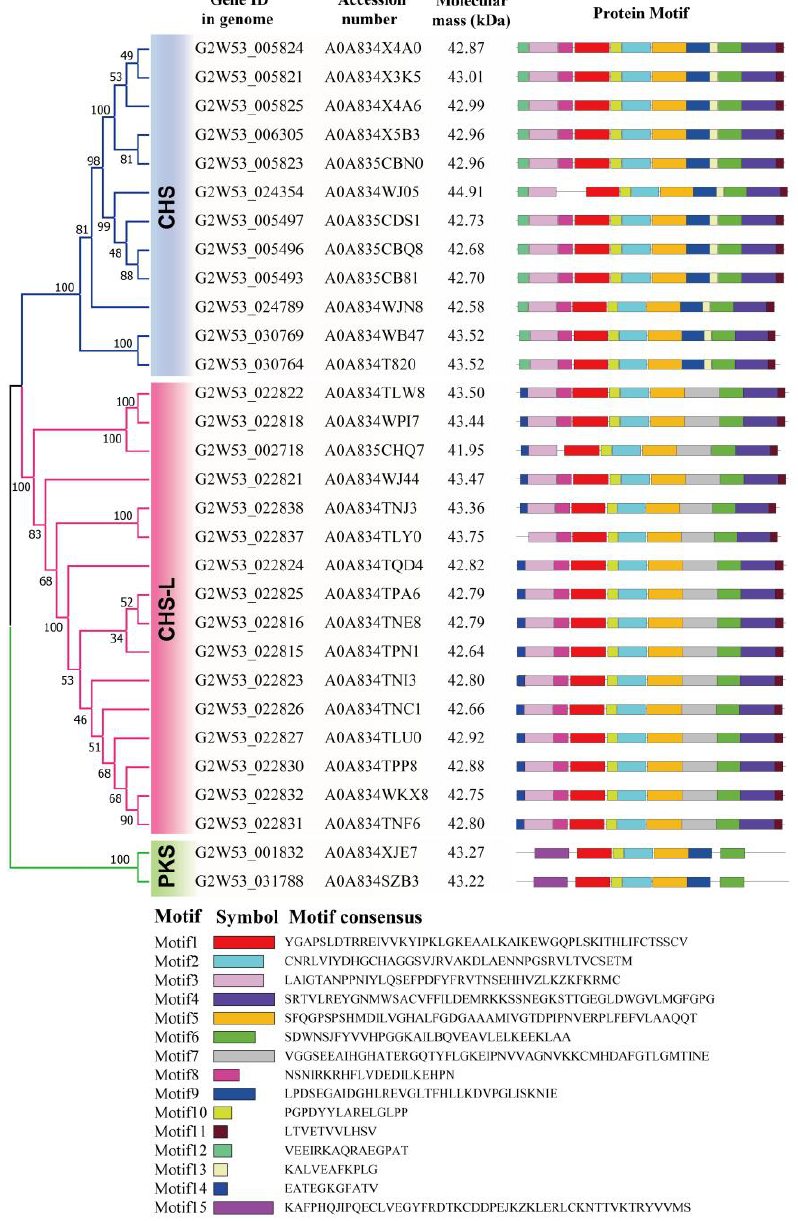
Figure 3. The protein phylogenetic and conserved motif analysis of the type III PKS superfamily members in Senna tora . The deduced amino acid sequences of the type III PKSs were obtained from UniProt (https://www.uniprot.org), accessed on 9 December 2022. The phylogenetic tree was constructed using the neighbor-joining method with 1000 bootstrap replicates in the MEGA7 program. The 15 conserved motifs were identified by MEME and are represented by different colored boxes.